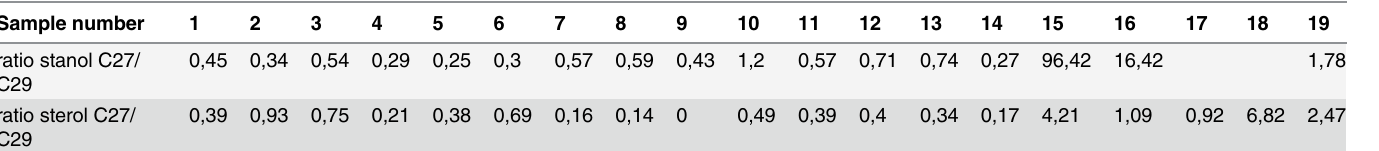
Table 2. Stanol and sterol ratios.